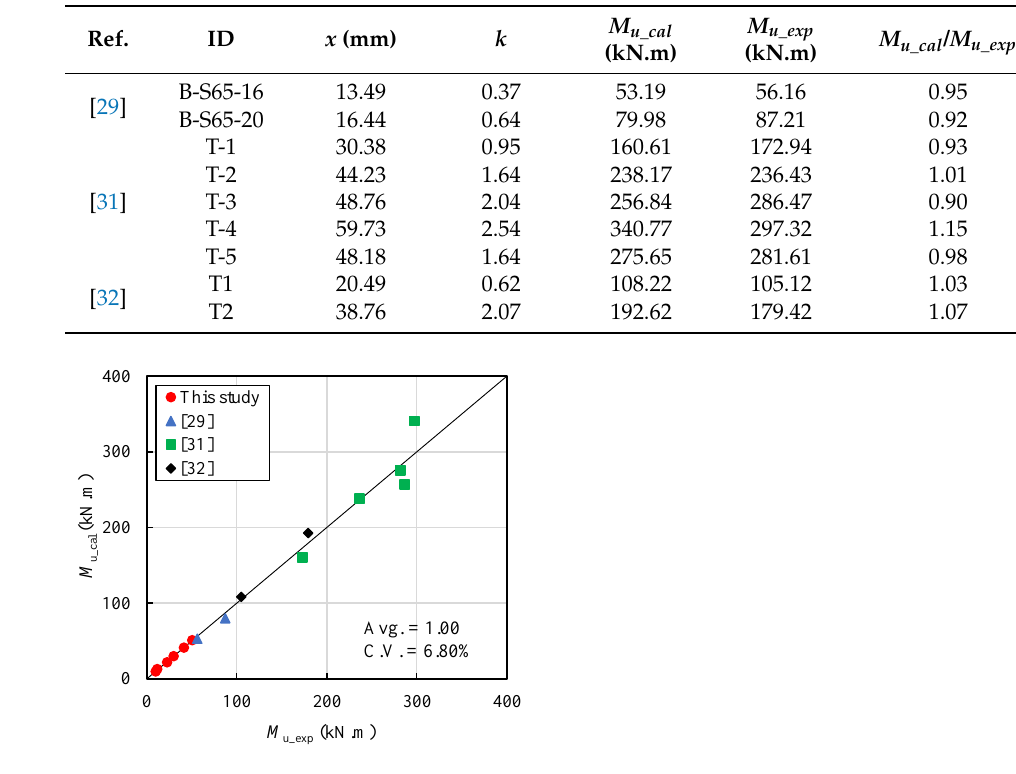
Figure 16. Validity of